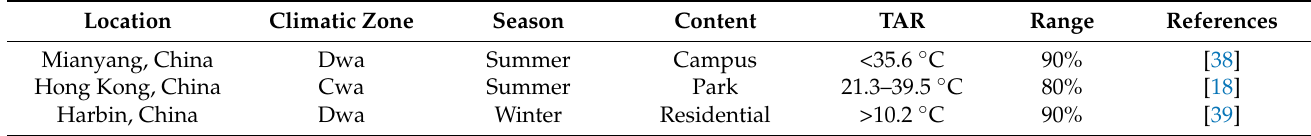
Table 6. Thermal acceptability range from other OTC